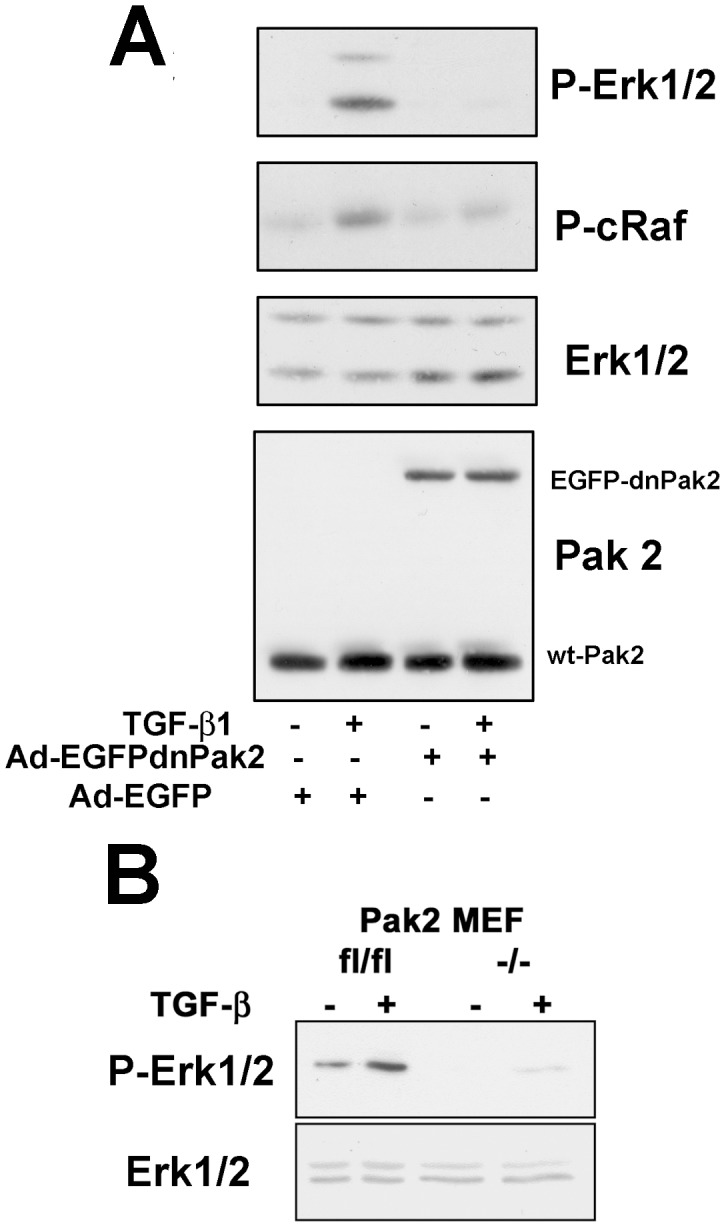
Erk activation requires activation of Pak2 and c-Raf.(A) AKR-2B fibroblasts were infected at an MOI of 1∶125 with adenovirus containing either dominant-negative PAK2 (Ad-EGFPdnPAK2) or Ad-EGFP as a negative control. Cells were treated with TGF-β (2 ng/ml) for 2 h prior to lysis. Cell lysates were then probed for phospho-Erk, and phospho-c-Raf (Ser338). The phospho-Erk1/2, and the stripped/reprobed total Erk loading control blot was obtained using the lower molecular mass portion of the same blot as that for P-cRaf. The same cell lysates were analyzed on a separate blot for PAK2 to confirm expression. (B) Cell lysates were analyzed for phospho-Erk and total Erk levels, in MEF cells that contained the Pak2 gene with flanking flox sites and a MEF cell line derived from this parental line in which Cre recombinase had been used to excise the Pak2 gene, following treatment with or without TGF-β for 2 h.